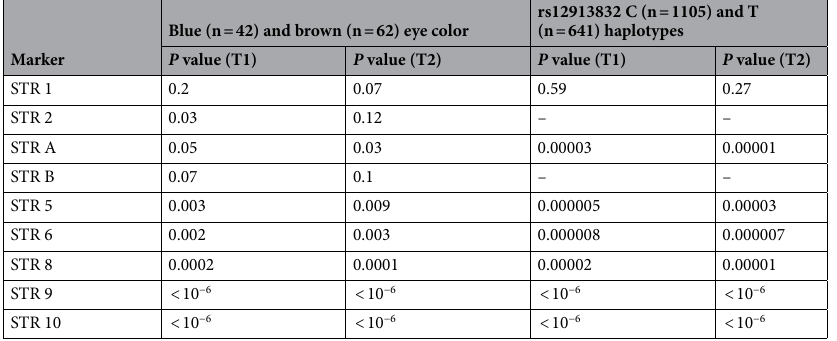
Table 2. Significance of allele frequency differences between predicted blue and brown eye color HGDP- CEPH Europeans and between European haplotypes containing rs12913832 C and T. The significance of allele frequency differences between predicted blue and brown eye color individuals was estimated by Monte Carlo approaches using the program ‘clump’ 61 . T1: Normal chi-square with significance assessed by Monte Carlo simulations. T2: Chi-square from table after collapsing columns with small expected values together and significance assessed by Monte Carlo simulations.